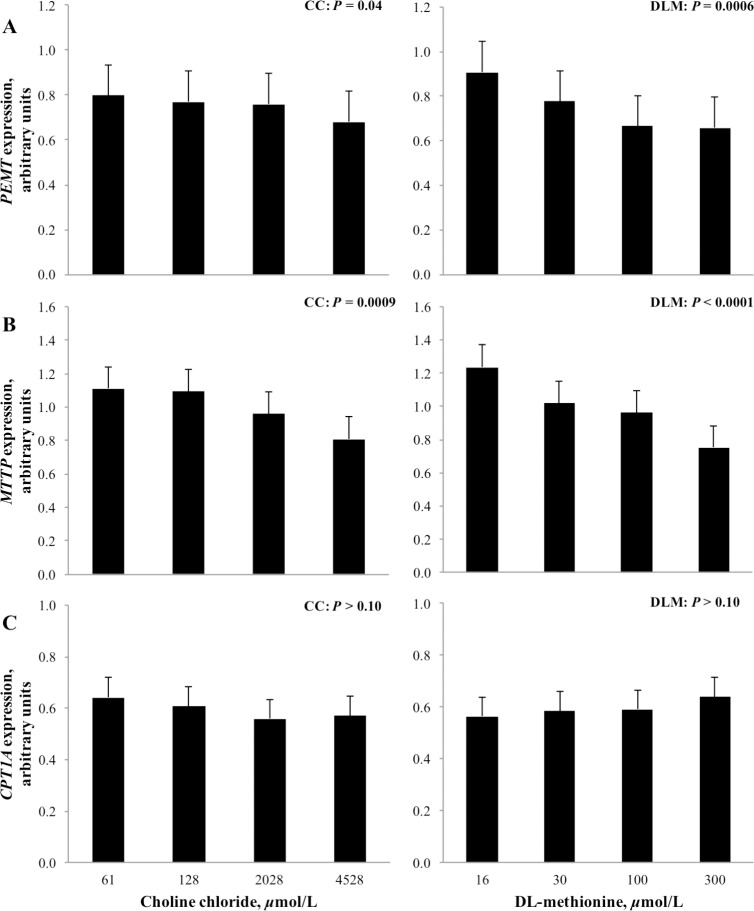
Expression of genes related to lipid metabolism and oxidation in neonatal bovine hepatocytes exposed to increasing concentrations of choline chloride (CC) and DL-methionine (DLM); there were no interactions between CC and DLM.Values are least squares means, with SE represented by vertical bars. Phosphatidylethanolamine N-methyltransferase (PEMT), microsomal triglyceride transfer protein (MTTP), carnitine palmitoyltransferase 1A (CPT1A).